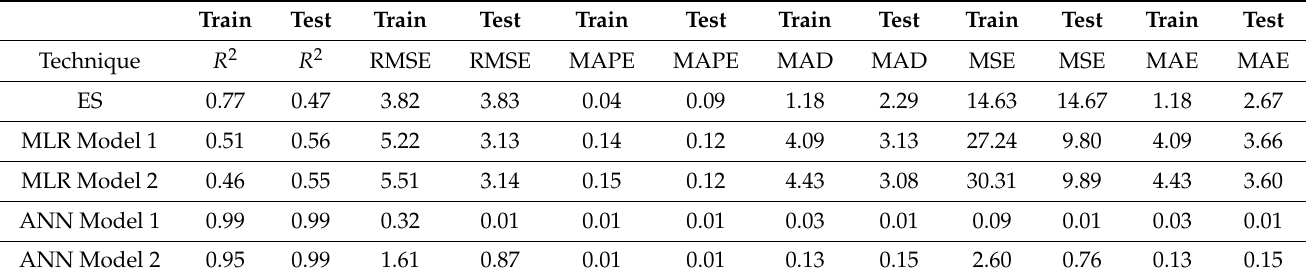
Table 6. Performance of the developed predictive